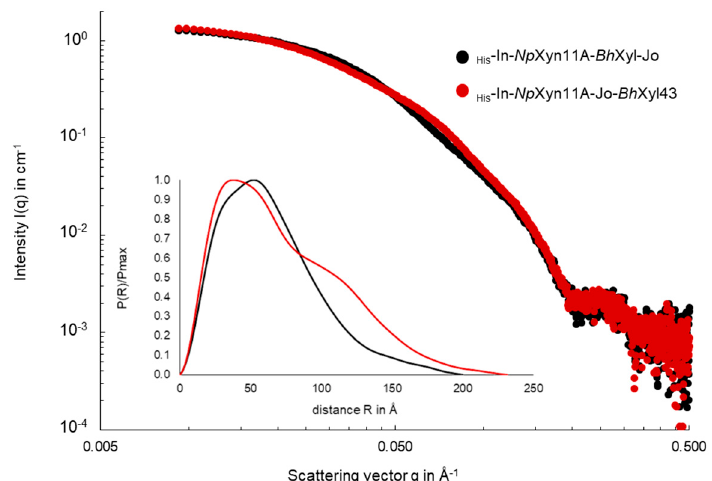
Figure 2. Superimposition of SAXS data from His -In- Np Xyn11A- Bh Xyl43-Jo and His -In- Np Xyn11A-Jo- Bh Xyl43 constructs (black and red dots respectively). The data are presented as a plot of Log I(q) in cm − 1 vs. Log q in Å − 1 to magnify the region of small angles. In the box below is represented the pair distribution function p(r) of each form, plotted as a function of P(r) / Pmax vs. r in